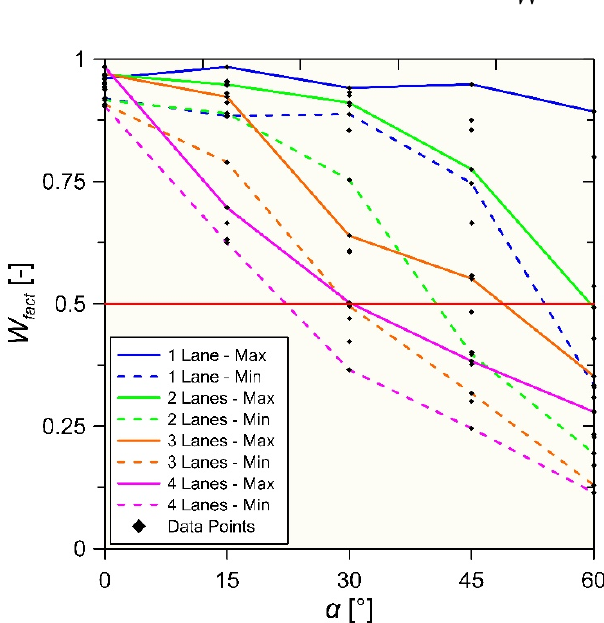
Figure 9. Relation of effective width to bridge width for live load bending moment from LFEA, showing data of all 80 case study bridges.